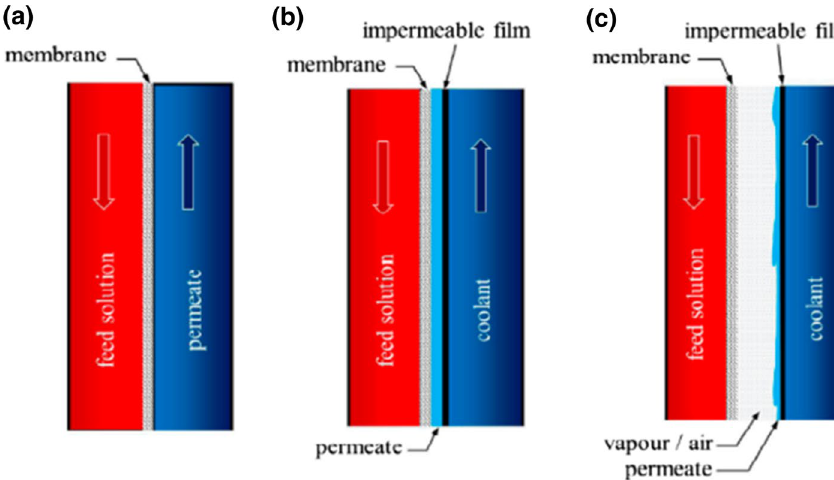
Fig. 3 MD configurations driven by a temperature differ- ence: a DCMD, b PGMD and